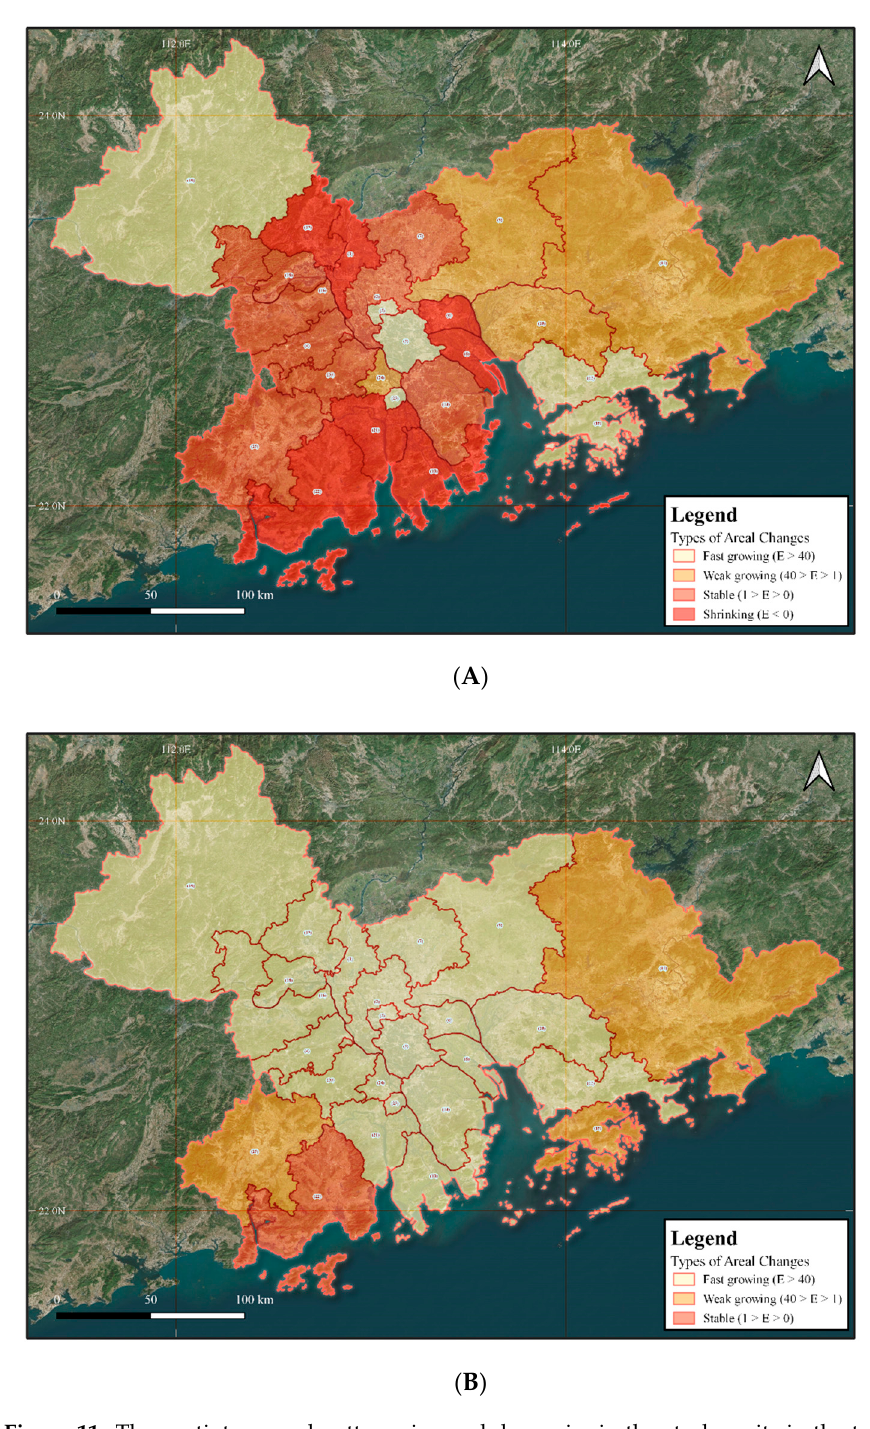
Figure 11. The spatiotemporal patterns in areal dynamics in the study units in the two different stages: ( A ) the first stage from 1986 to 2013; ( B ) the second stage from 2013 to 2019.